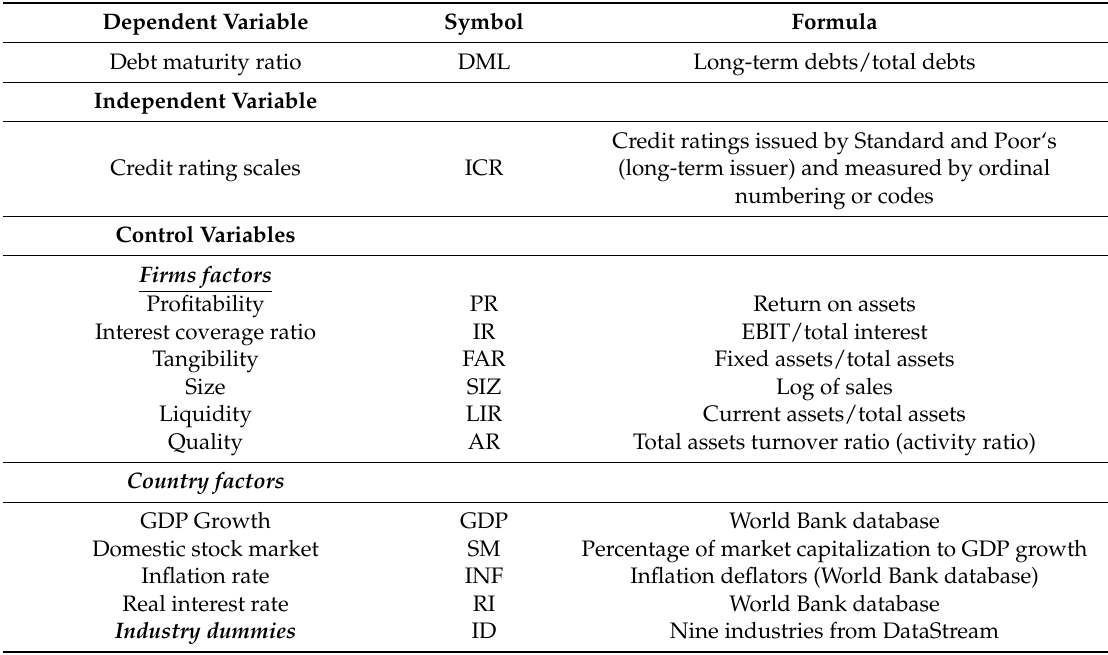
Table 2. The theoretical